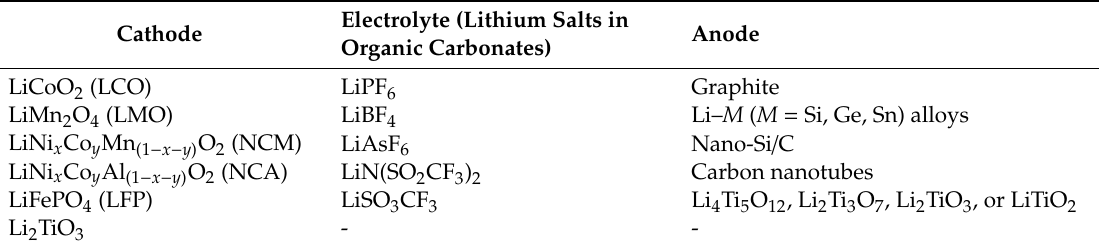
Table 4. List of representative electrode materials in rechargeable Li-ion batteries